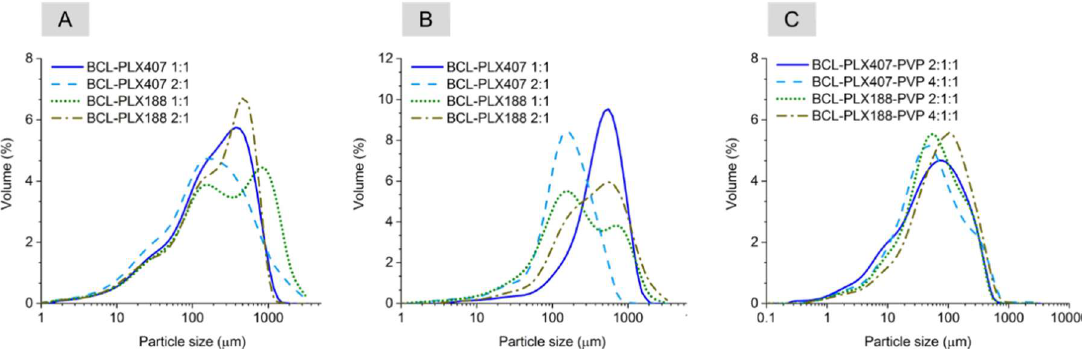
Figure 1. Particle size distribution of solid dispersions obtained by evaporation technique ( A ) and spray drying of binary ( B ) and ternary systems ( C ). BCL: bicalutamide; PLX: poloxamer; PVP: polyvinylpyrrolidone.